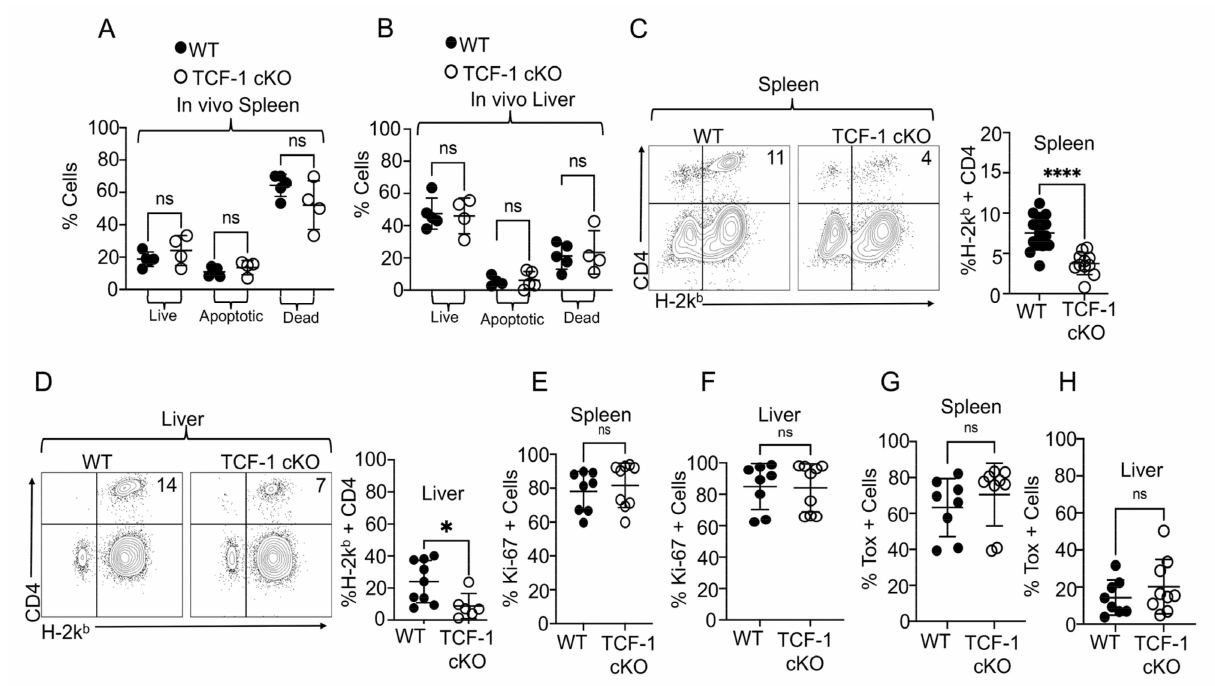
Figure 6. TCF-1 regulates donor T cell presence but has no effect on T cell exhaustion during alloimmunity. Recipient mice were allotransplanted, as described in Figure 1 with CD4 T cells from WT or TCF-1 cKO mice. At day 7, spleens and livers were taken from euthanized recipients. Lymphocytes were isolated and stained for H2Kb to identify donor cells then gated on CD3, CD4, and with annexin V-FITC and LIVE/DEAD near IR. Cells were identified as live (Ann.V-, IR-),